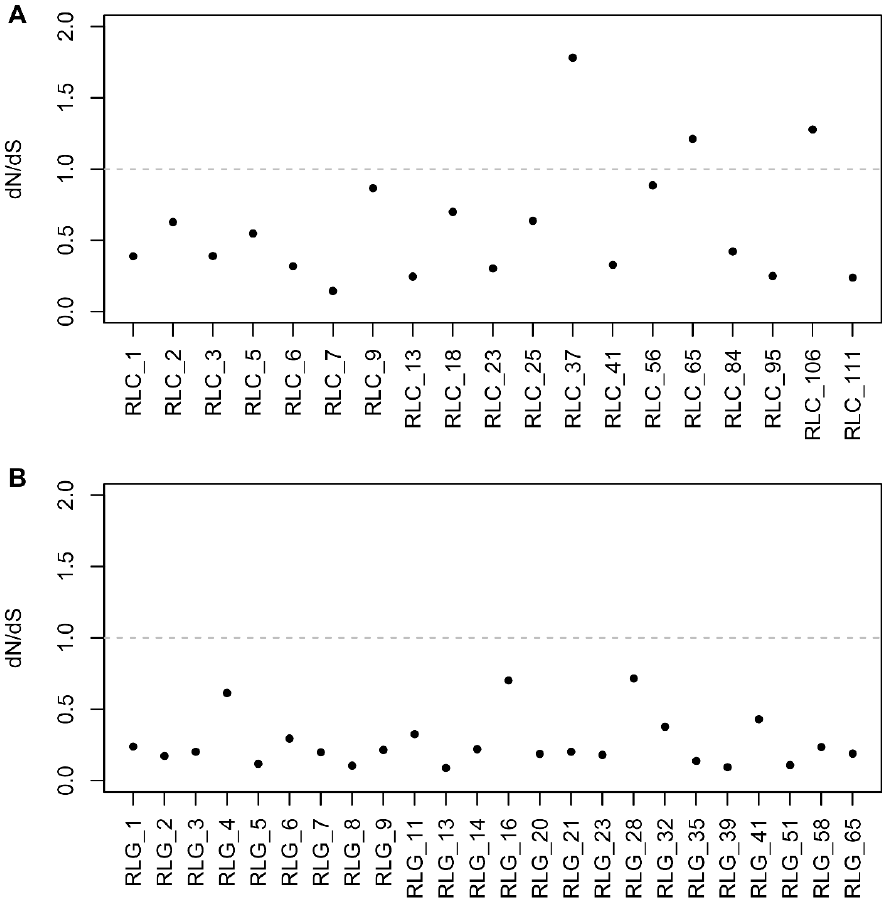
Figure 7. Nonsynonymous/Synonymous (dN/dS) rates for the LTR retrotransposons. ( A ) dN/dS rates for the Copia elements; ( B ) dN/dS rates for the Gypsy elements. The x -axis represents different families. The y -axis displays values of dN/dS. Only full-length sequences with intact RT genes were retained for selective pressure analysis. Protein sequences of RT genes were aligned by MUSCLE, then PAN2NAL was utilized to convert the protein MSA (multiple sequence alignment) format to a DNA codon-based alignment with the universal code model. The codeml module was used to perform dN/dS calculations. The rates of dN/dS reflected the selective pressures of these elements, dN/dS < 1, dN/dS = 1, and dN/dS > 1 denote purifying selection, neutral mutations, and adaptive molecular evolution, respectively.